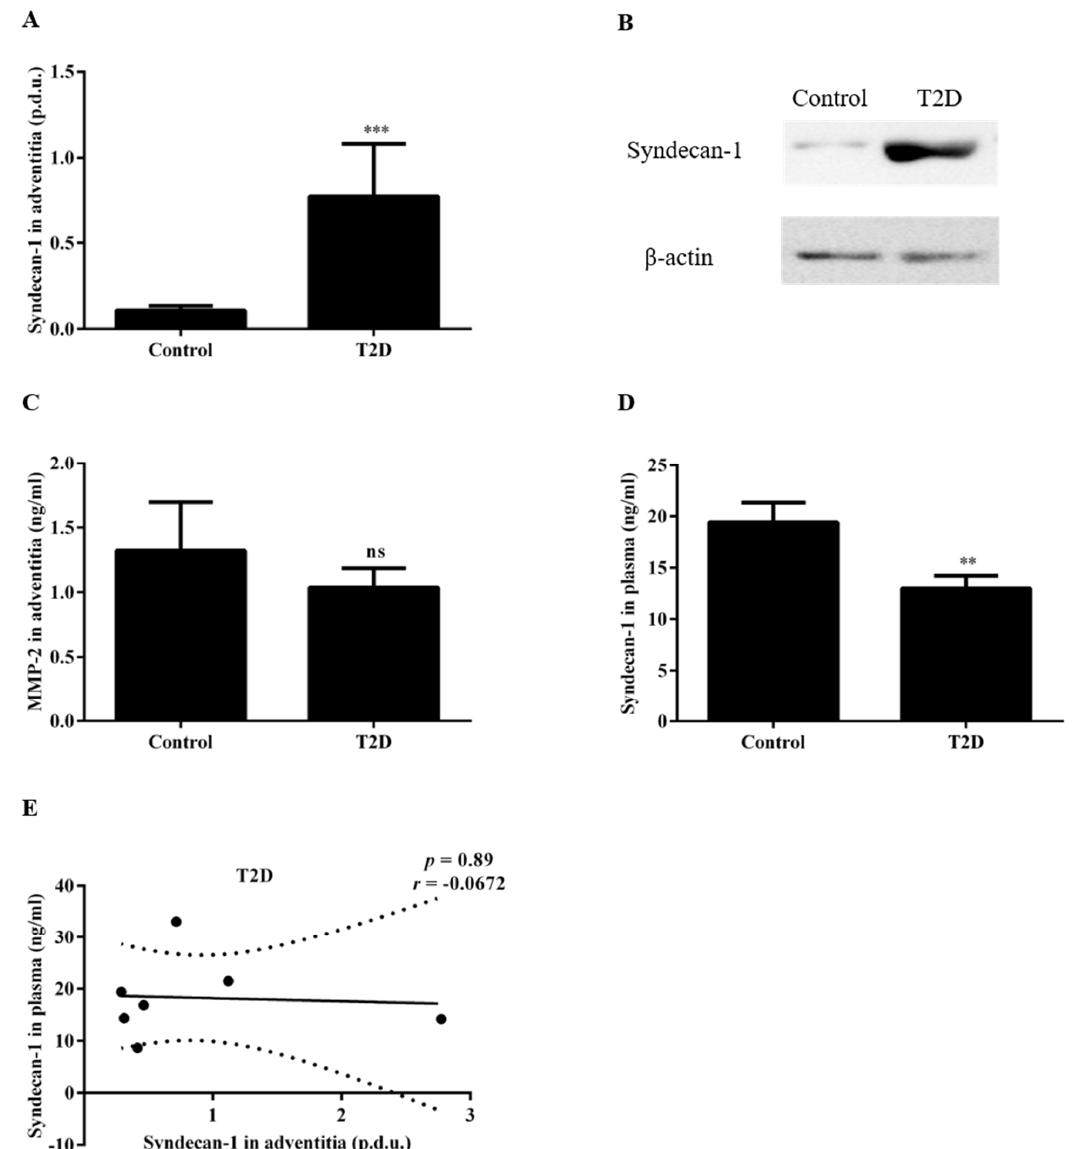
Figure 2. Type 2 diabetes was associated with decreased plasma Sdc-1 and an increased expression of Sdc-1 in the aortic tissue. The Sdc-1 expression in the adventitia was significantly increased in T2D patients ( A ) normalized data and ( B ) Western blot data (the full-length blot is provided in Supplementary Material Figure S3); ( C ) MMP-2 activity in the adventitia was not changed due to T2D; ( D ) The plasma Sdc-1 was significantly decreased in the same patient group. ( E ) The expression of Sdc-1 in the adventitia was not associated with Sdc-1 in plasma. Comparisons between the groups were made using an unpaired t-test or a Mann–Whitney. A Pearson correlation was used to assess the associations. For plasma, n = 36 for the control and n = 30 for T2D; for tissue, n = 10 for the control and n = 9 for T2D. ** p < 0.01, *** p < 0.001, ns = not significant.